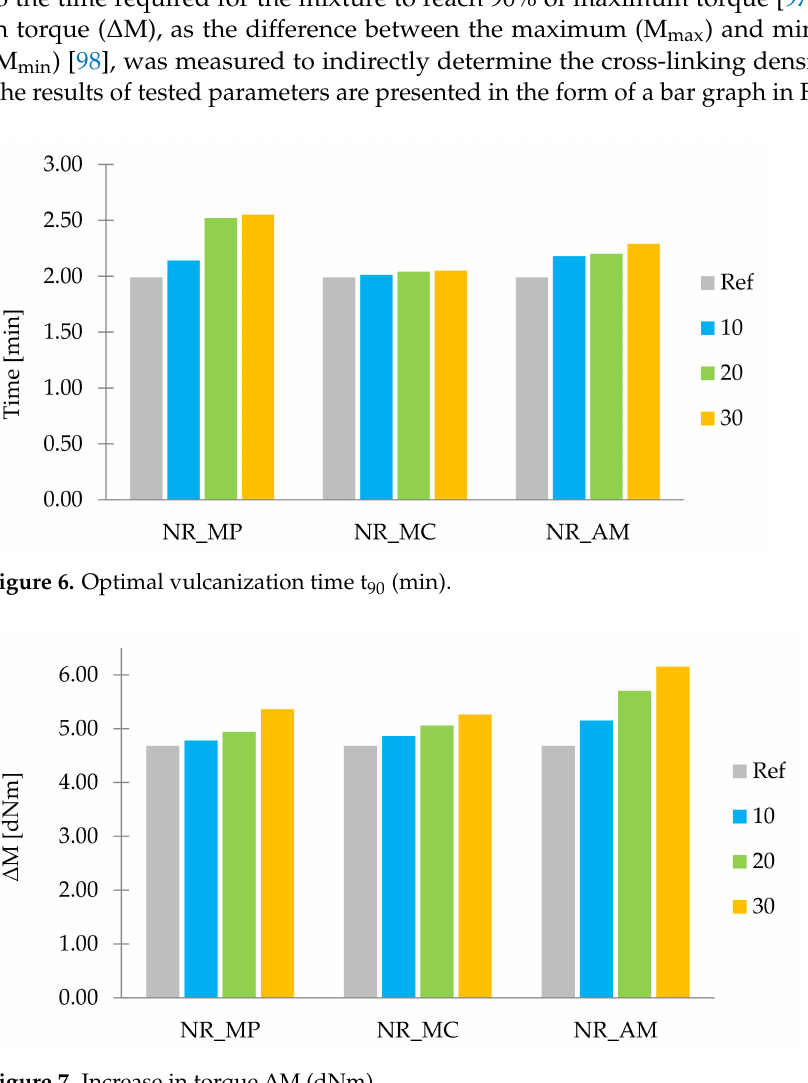
Figure 7. Increase in torque ∆ M